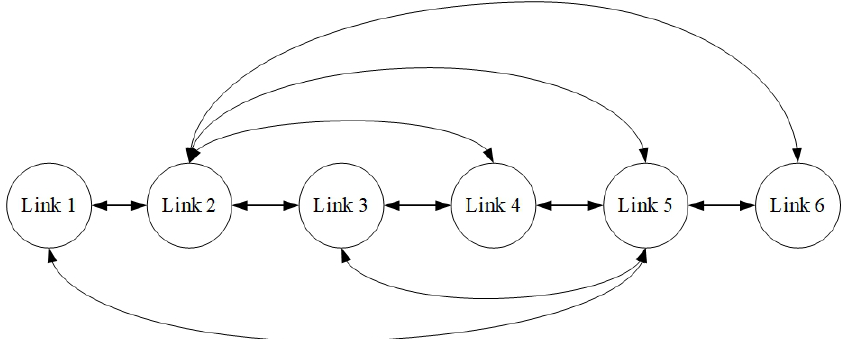
Figure 3. Link interference graph used in the simulations.